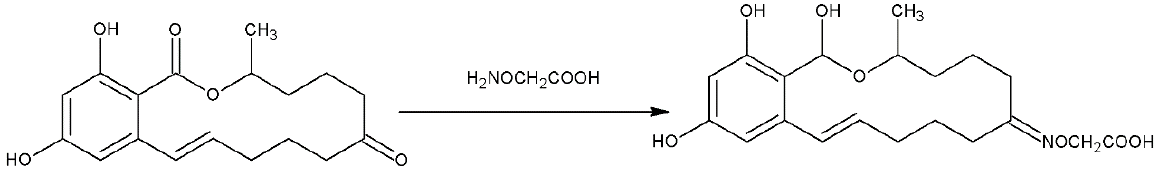
Fig. 2. ZEN-CMO synthesis